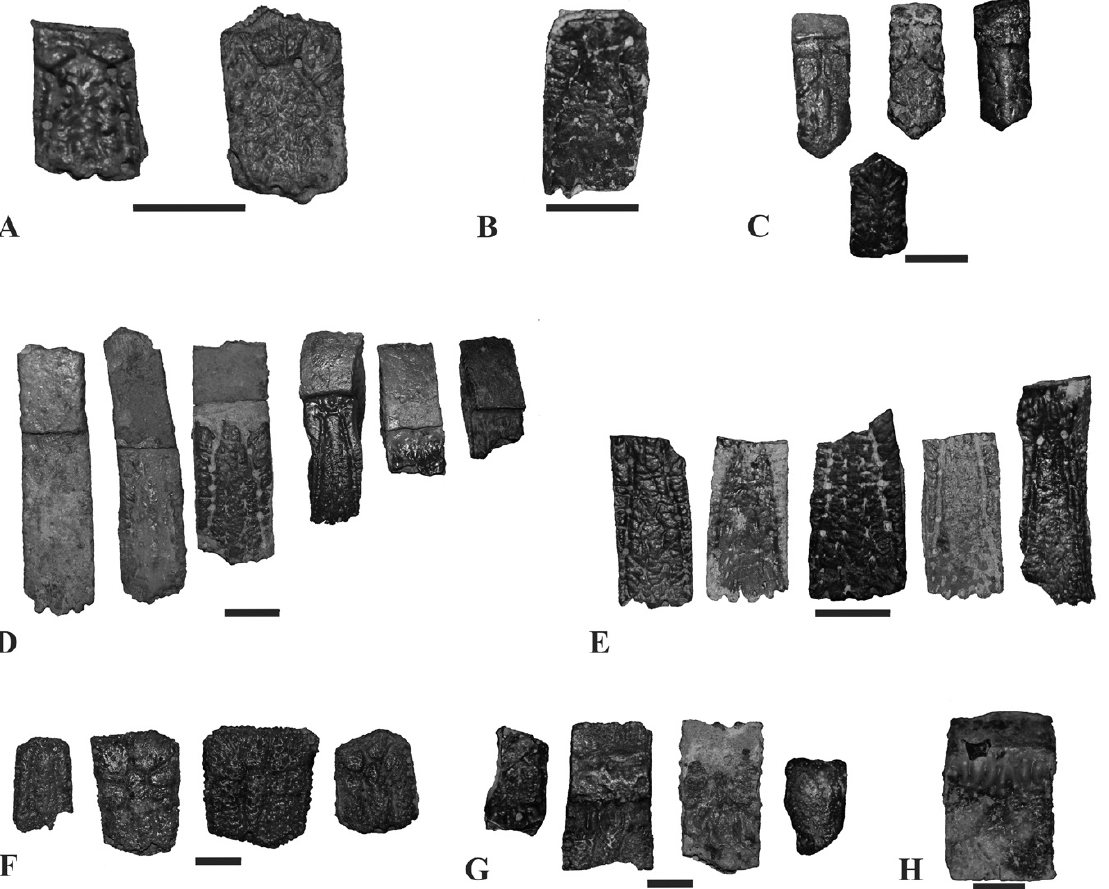
Figure 4 - Dasypus aff. D. novemcinctus . A. MDJ M-831 and 873, fixed osteoderms; B. MDJ M-834, semi-moveable osteoderm; C. MDJ M-869, 862, 882 (at top) and 859 (at bottom), caudal osteoderms; D-E. MDJ M-804, 826, 825, 827, 809, 851, 833, 817, 836, 829 and 830, left to right, fragmentary moveable osteoderms. Euphractus sexcinctus . F. MDJ M-803, 801, 821 and 822, left to right, fixed osteoderms; G. MDJ M-852, 824, 823 and 872, left to right, fragmentary moveable osteoderms. Cabassous sp. H. MDJ M-840, moveable osteoderm. All osteoderms are in dorsal view. Scale bars = 0.5